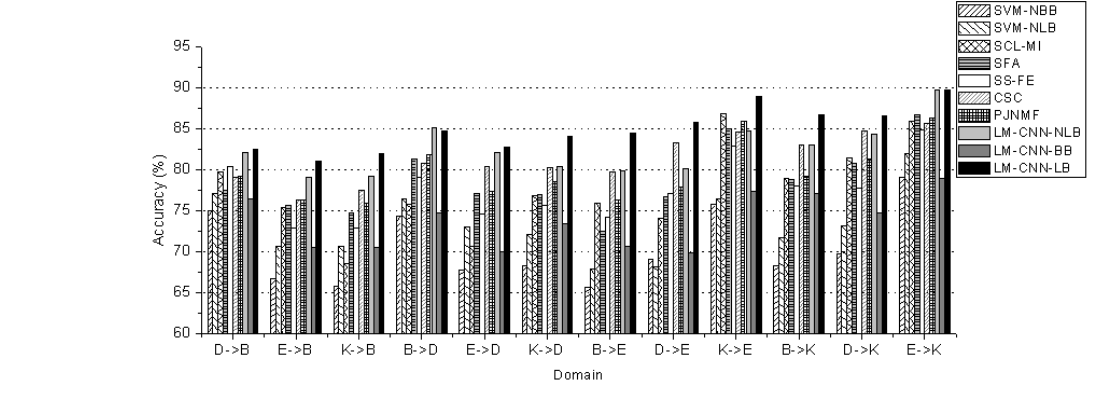
Figure 2. Comparison of different methods on the benchmark dataset for cross-domain sentiment